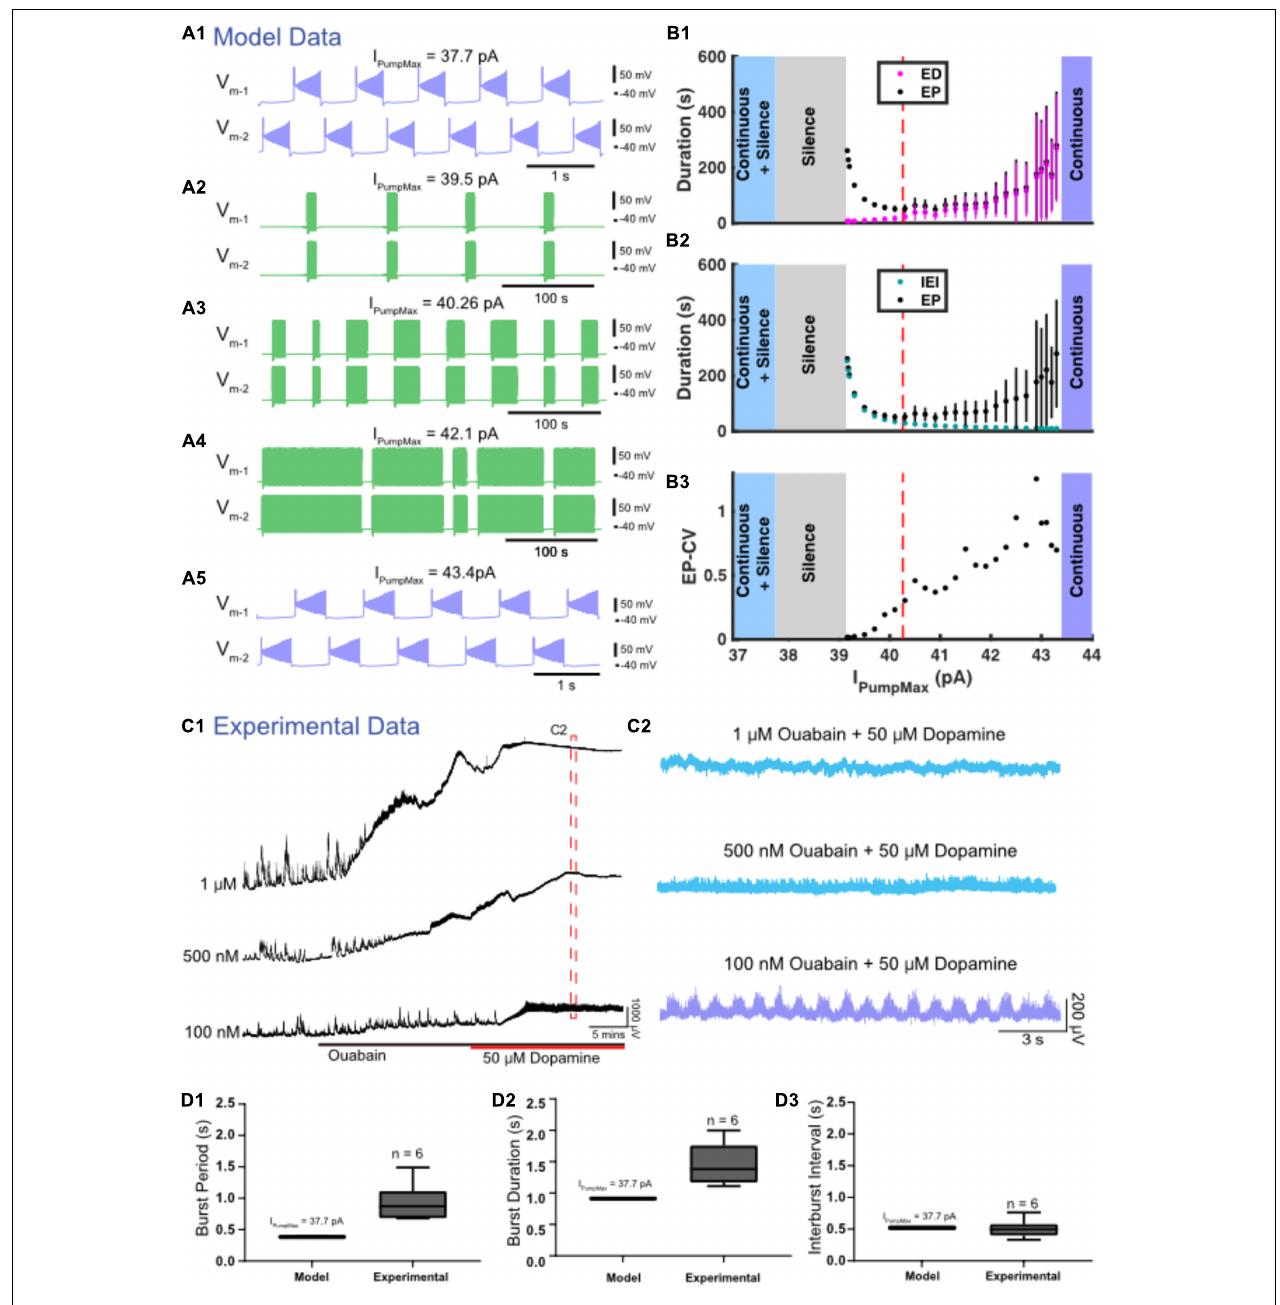
FIGURE 6 | Variation in I PumpMax modulates episodic bursting properties and produces transitions between episodic and continuous rhythmicity. (A) Examples of various activity types produced at different values of the maximal pump strength ( I PumpMax ) are depicted. (A1) Continuous bursting occurs at I PumpMax = 37.7 pA. (A2) Episodic activity occurs at I PumpMax = 39.3 pA with long interepisode intervals (IEIs) and short episode durations (EDs). (A3) At I PumpMax = 40.26 pA (canonical), episodic activity occurs with moderately variable EDs. (A4) At I PumpMax = 42.1 pA, episodic activity occurs with highly variable EDs and short IEIs. (A5) Continuous bursting occurs at I PumpMax = 43.4 pA. (B) Graphs depict the relationship between I PumpMax and episode parameters as well as transitions between regimes. (B1) EP (black dots), EP variability (black bars) and ED (magenta dots) and ED variability (magenta bars) are shown versus I PumpMax . (B2) EP (black dots) and IEI (cyan dots) are shown versus I PumpMax . (B3) EP-CV versus I PumpMax . (C1) Extracellular neurograms of spontaneous activity recorded in DC from ventral roots during application of 1 µ M ( n = 6), 500 nM ( n = 7), and 100 nM ( n = 6) of ouabain (black bar) and subsequent application of dopamine (50 µ M: red bar). (C2) Neurograms displaying network activity elicited by dopamine in the presence of different concentrations of ouabain highlighted in (C1) . (D) Box and whisker plots depict interquartile range (boxes), median (horizontal black lines), maximum and minimum values in the data range (whiskers) for burst period (BP: D1 ), burst duration (BD: D2 ), and interburst interval (IBI: D3 ) during continuous bursting generated by the Model HCO with I PumpMax = 37.7 pA compared to continuous bursting generated by isolated spinal cords (Experimental) in the presence of 50 µ M dopamine and 100 nM ouabain.